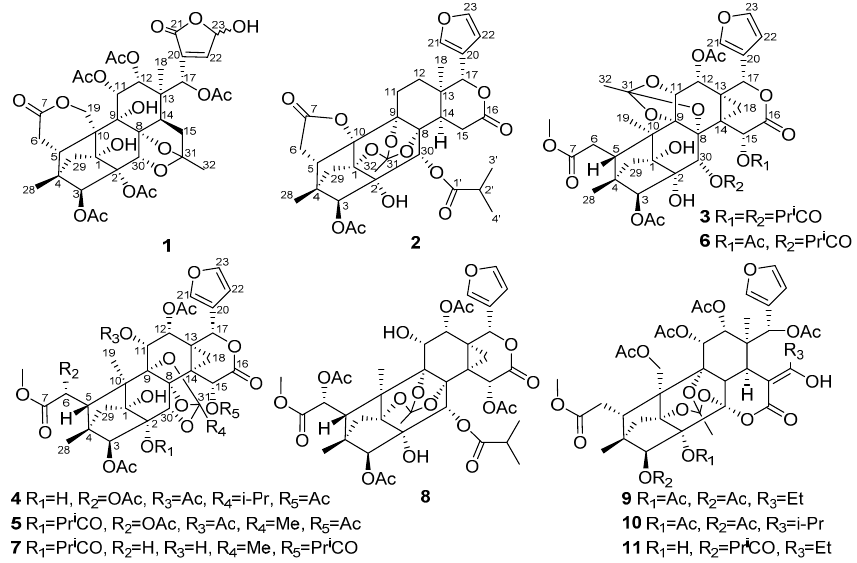
Figure 1. Structures of compounds 1 – 11 .